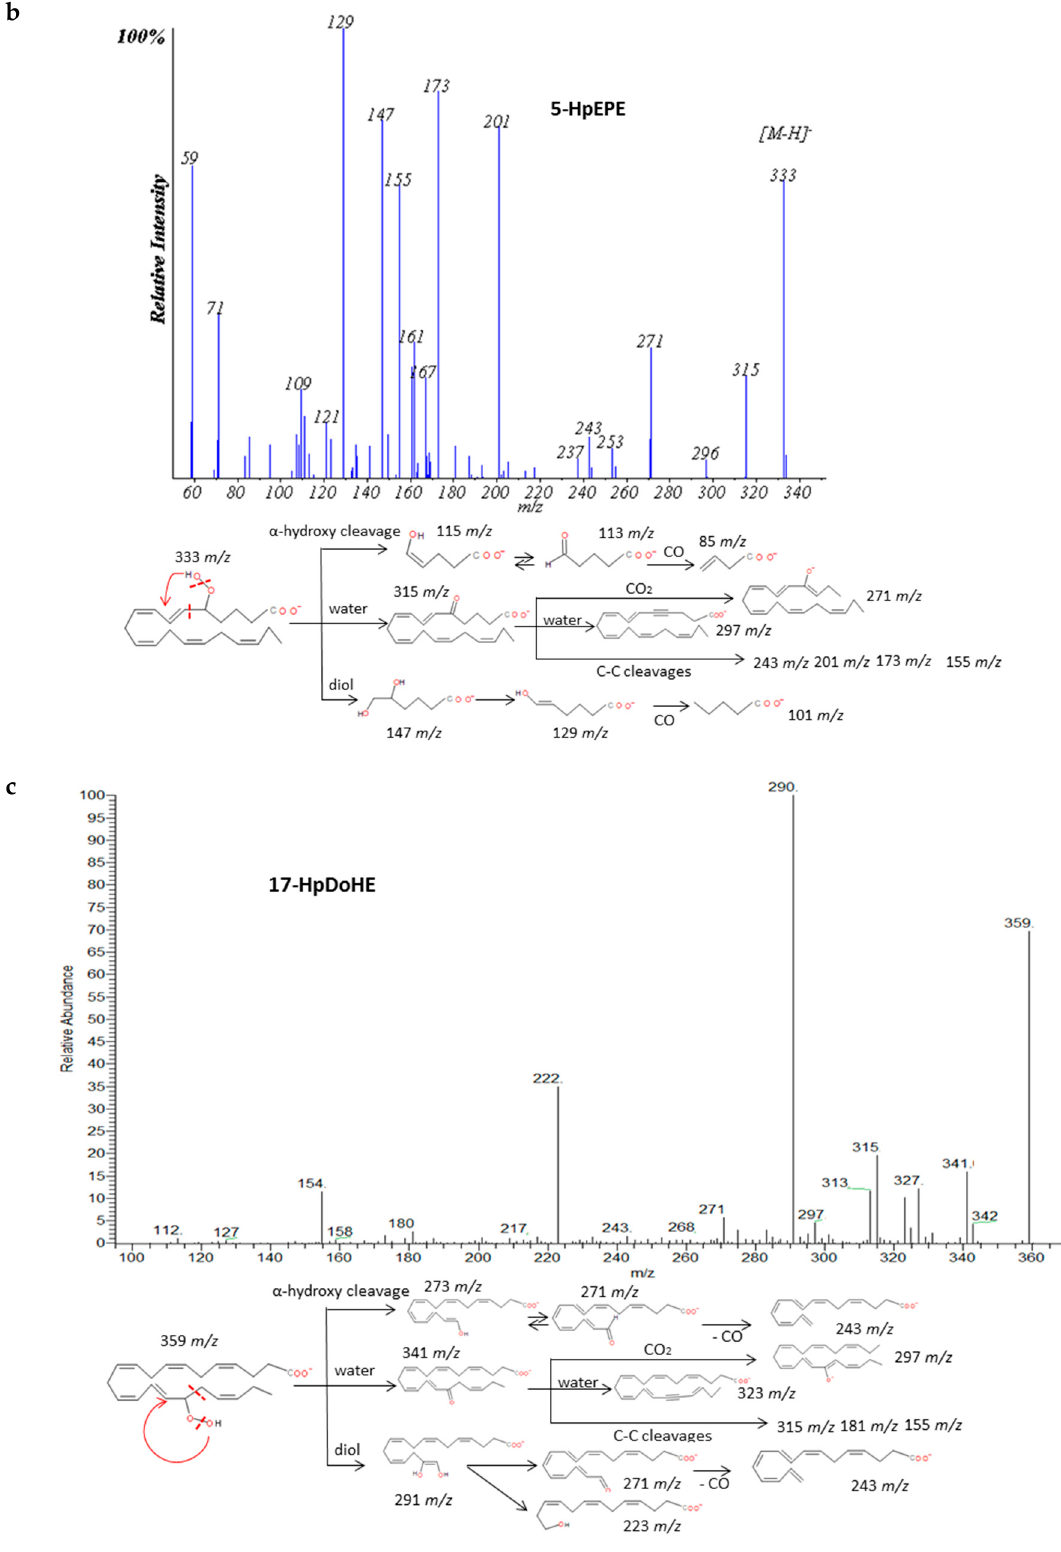
Figure 3. Fragmentation pattern suggested for ( a ) ARA, ( b ) EPA and ( c ) DHA hydroperoxides. Common cleavages and specific transitions for 5-HpETE, 5-HpEPE, and 17-HpDoHE. Product ion spectra at m / z 335 for 5-HpETE, m / z 333 for 15-HpEPE, and m / z 359 for 17-HpDoHE were obtained from the LIPID MAPS database at CID